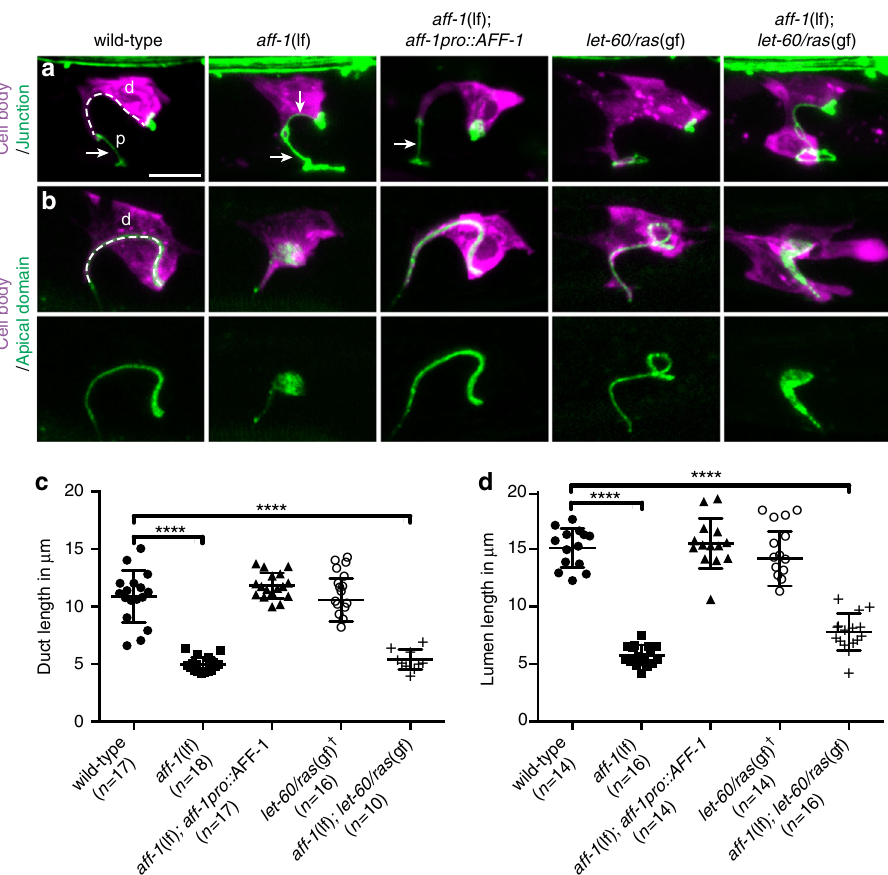
Fig. 2 AFF-1 is necessary for duct cell and lumen elongation. a , b Confocal Z-projections of L1 stage larvae: d, duct; p, pore. Duct cell is labeled with lin-48pro::mRFP (magenta). Cell junctions are labeled with ajm-1::GFP (green, a ), or apical domains are labeled with let-653::SfGFP (green, b ). Arrows indicate autocellular junction. The excretory duct cell body and lumen have an elongated shape in wild-type, aff-1 rescue and let-60 ( n1046gf ), but are shorter in aff-1 ( tm2214 ) and aff-1 ( tm2214 ); let-60 ( n1046gf ). c Measurements of duct cell length tracing from the pore-duct junction to the duct – canal junction, as demonstrated with the dotted line in “ a ” wild-type. Error bars = ± standard deviation (SD). d Measurements of duct lumen length, tracing as indicated with the dotted line in “ b ” wild-type. † = measure on a binucleate cell. Scale bar = 5 μ m. **** = p -value < 0.0001, Mann – Whitney